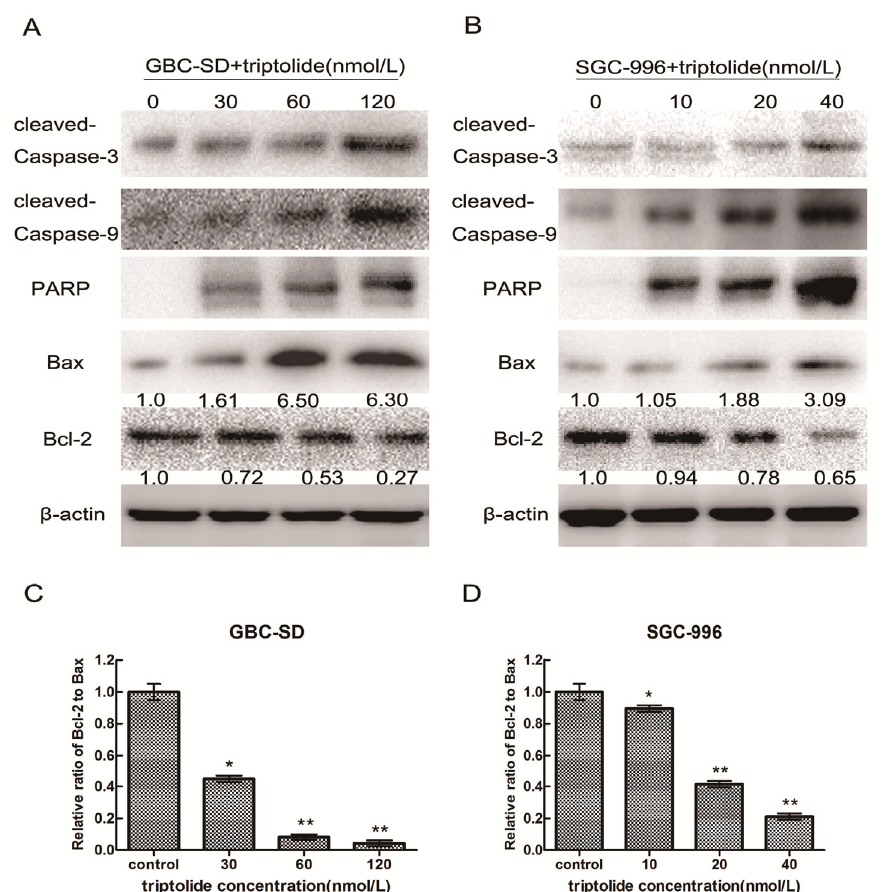
Figure 6. Triptolide regulates the expression of apoptosis-related proteins in gallbladder cancer cells. Expression of cleaved-caspase-3, cleaved-caspase-9, cleaved-PARP, Bax, and Bcl-2 in GBC-SD cells ( A ) and SGC-996 cells ( B ) treated with triptolide at the indicated doses for 48 h. β -actin was used as a loading control. ( C ) and ( D ), Ratio of Bcl-2 to Bax determined by band density, shown as mean ± SD, compared with the control (designated as 1.00). * p < 0.05; ** p <